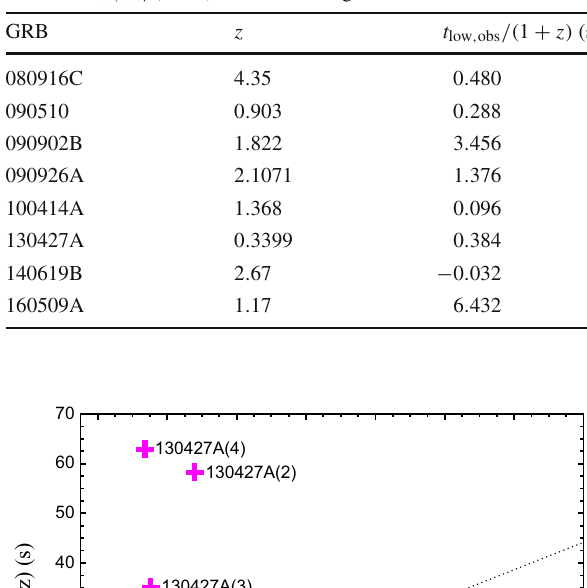
Table 2 t low , obs /( 1 + z ) chosen from light curves in Band-Obs